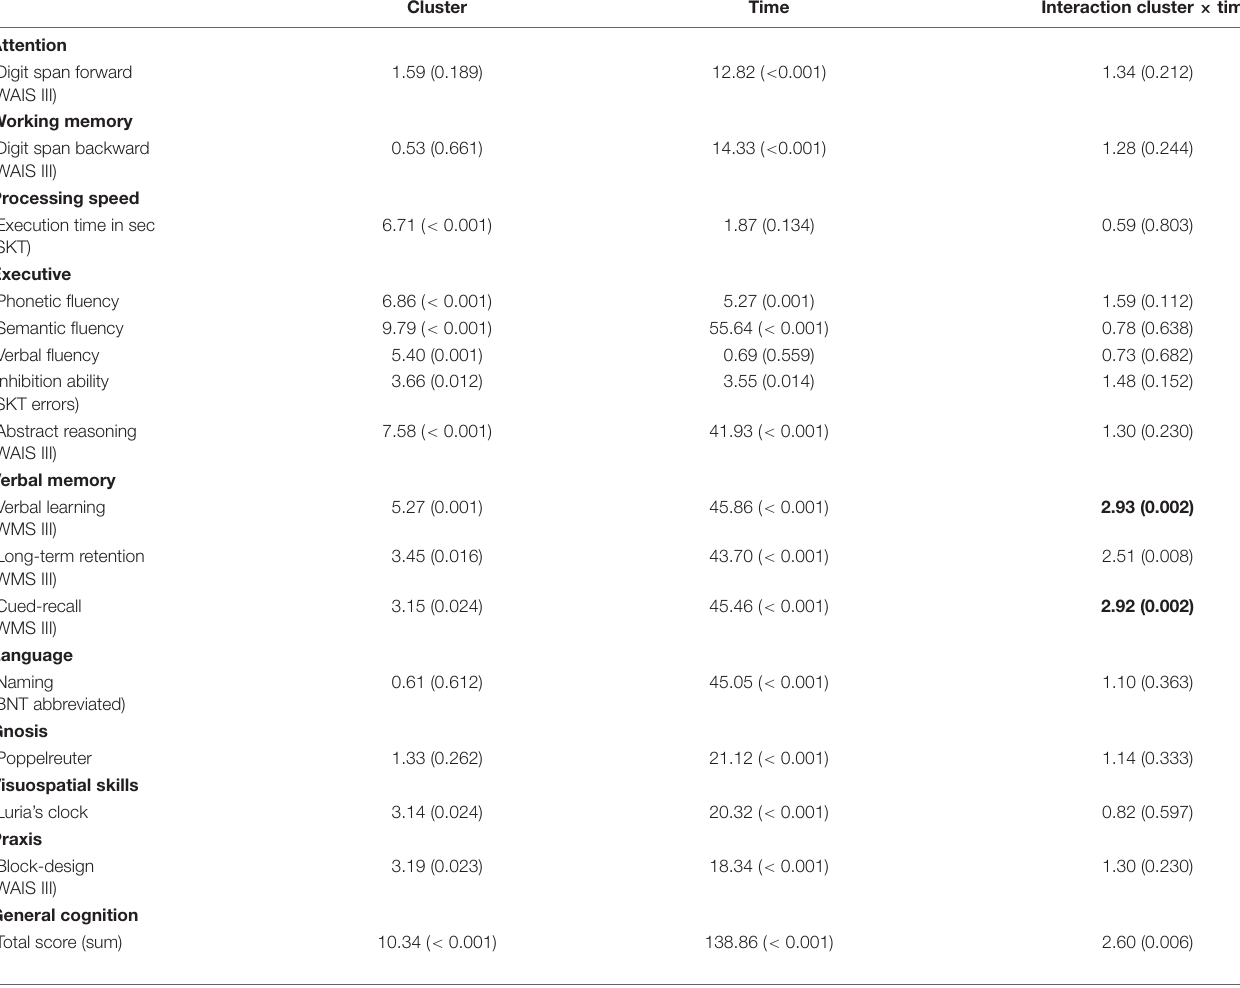
TABLE 2 | Linear mixed model results of cluster by time interaction and main effects in cognitive